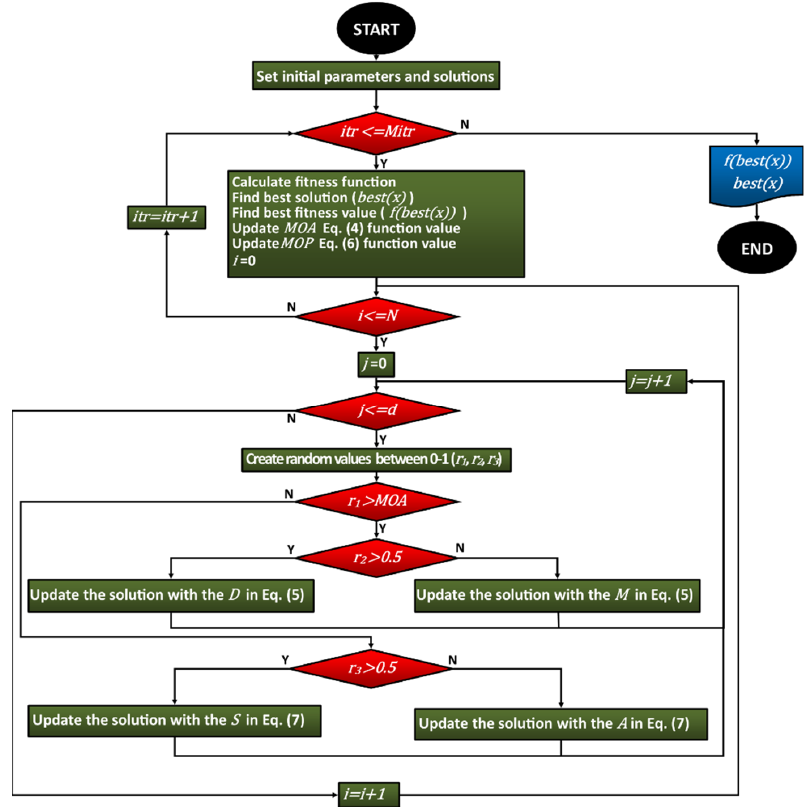
Fig. 2. Flowchart of AOA (Abualigah et al.,